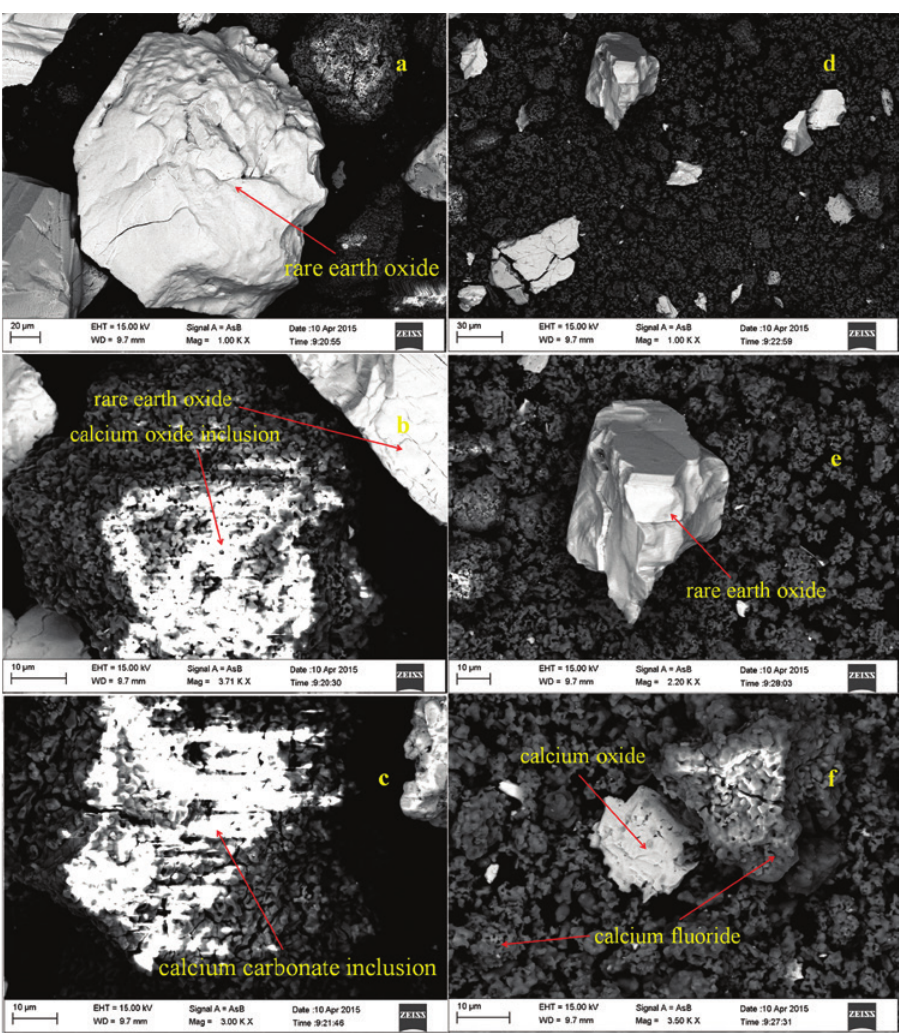
Figure 7: SEM image of calcification roasted